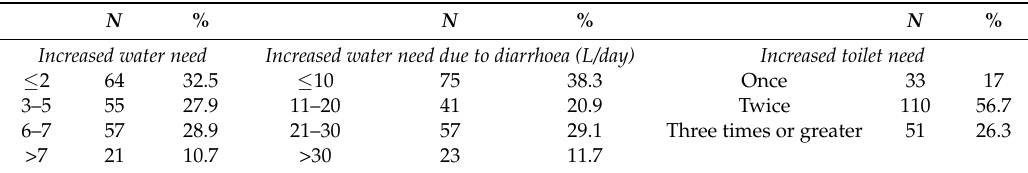
Table A4. Description of additional water and sanitation requirements among HIV-positive individuals following HIV-positive diagnosis ( N =